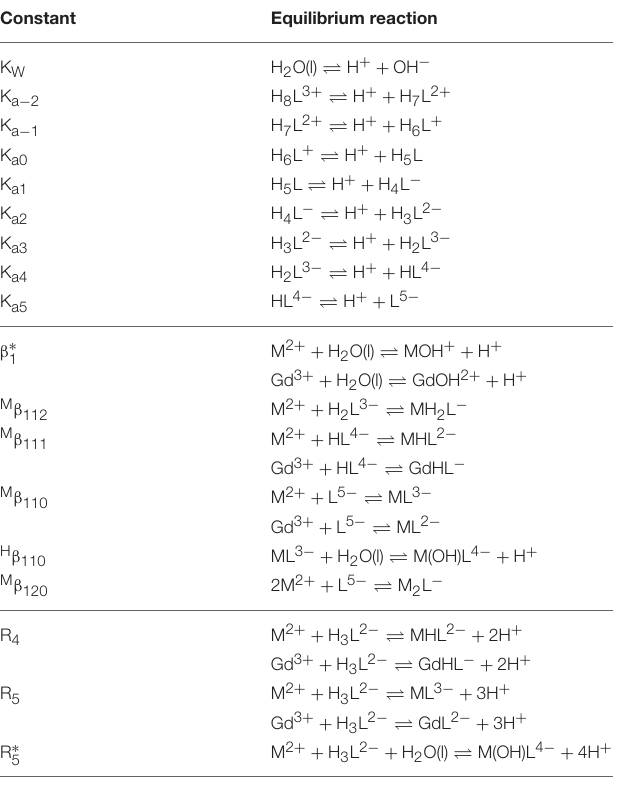
TABLE 1 | Definitions of equilibrium constants used throughout the text. Constant Equilibrium reaction